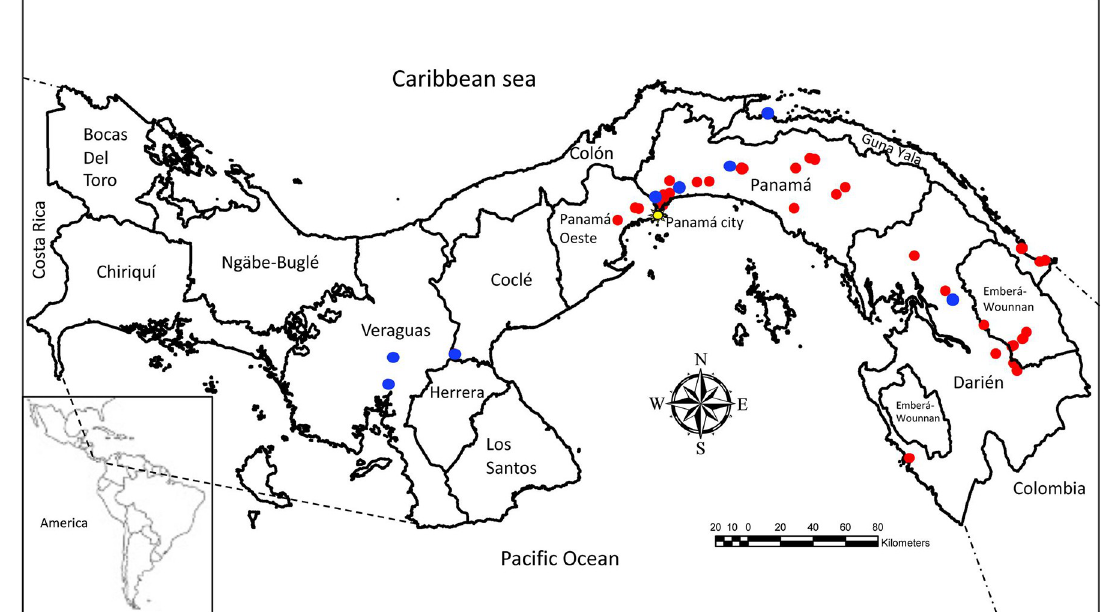
Fig 1. Plasmodium vivax samples collection sites. Map of Panama by province showing location of samples collection sites during 2017-2020. Red dots indicate P . vivax samples collection sites where one or more samples were collected. Blue dots indicate healthy control sample collection sites. Inset indicates location of Panama in the American continent. Base map downloaded from www.gadm. org under licence CC-BY. www.gadm.org/maps/PAN_1.html.